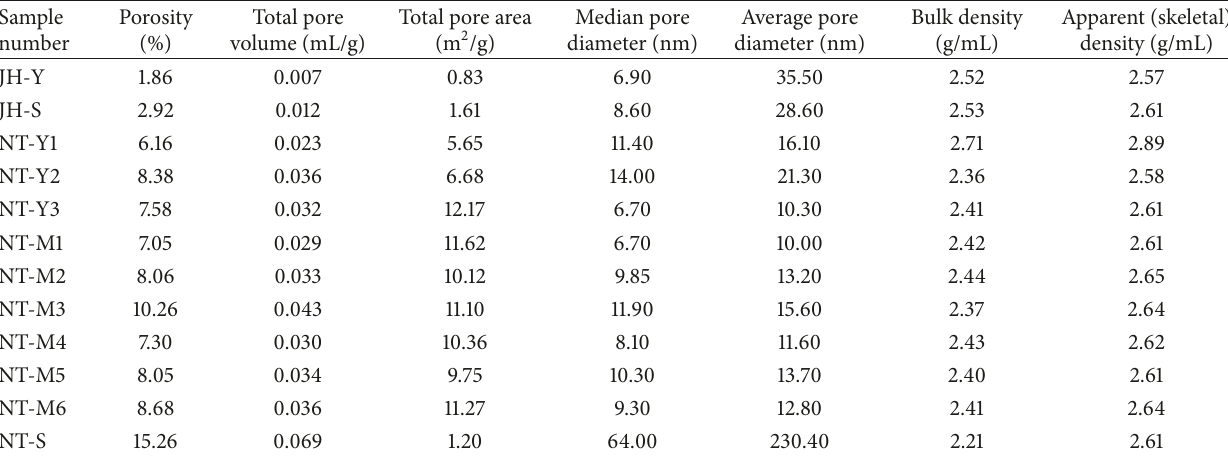
Figure 2: The FIB-SEM images of sample JH-Y ( 𝜑 Table 4: Parameters of pore-system structure measured by